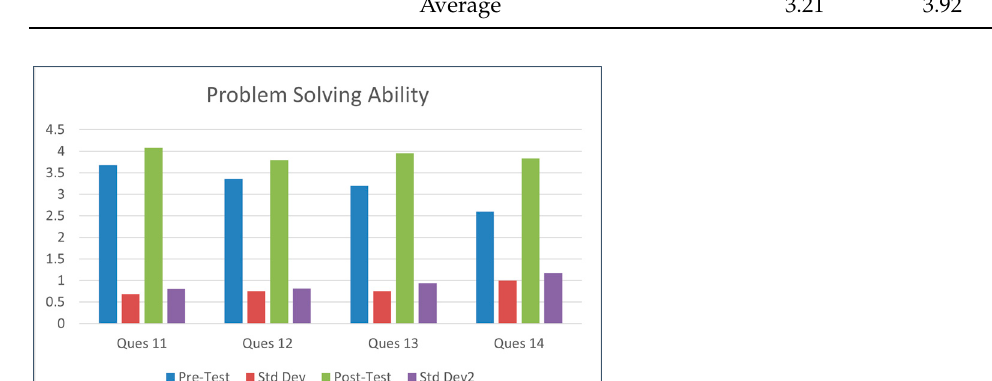
Table 6. The results for problem-solving ability.